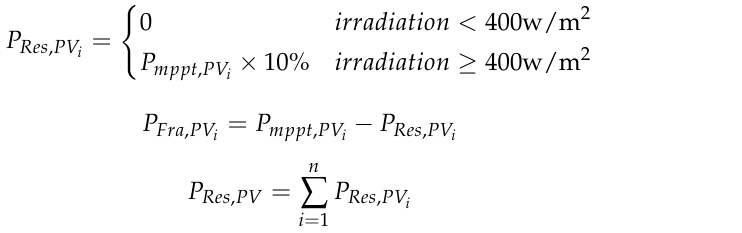
Figure 5. Irradiation received by module.